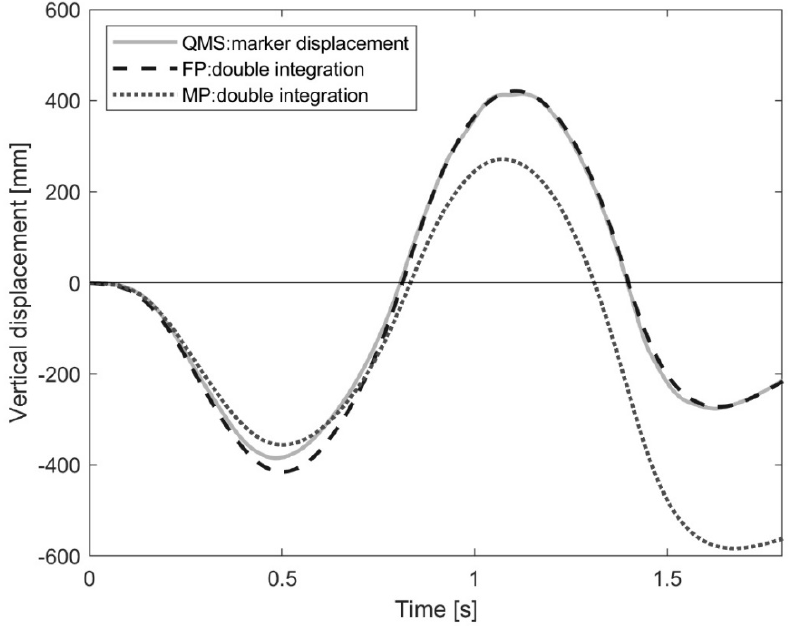
Figure 7. The vertical trajectories of the body centre mass, registered by QMS marker and determined by double integration method of the acceleration measured with FP and MP.